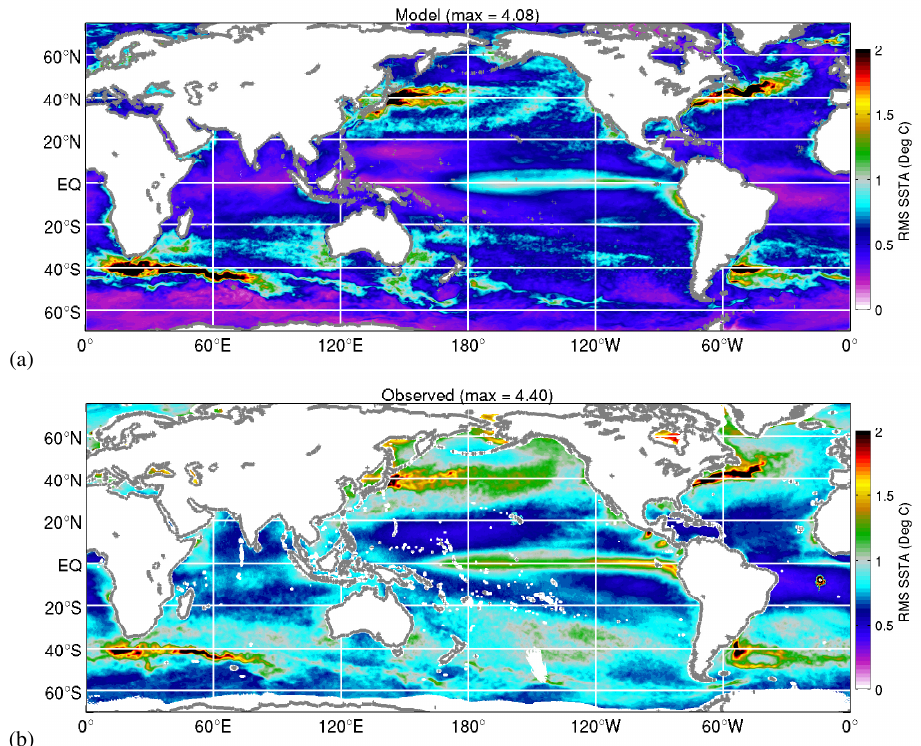
Fig. 9. Comparison of the RMS SLA from the (a) model and (b) observations. The title of each panel includes the global maximum value of RMS SLA that is off the colour scale used.